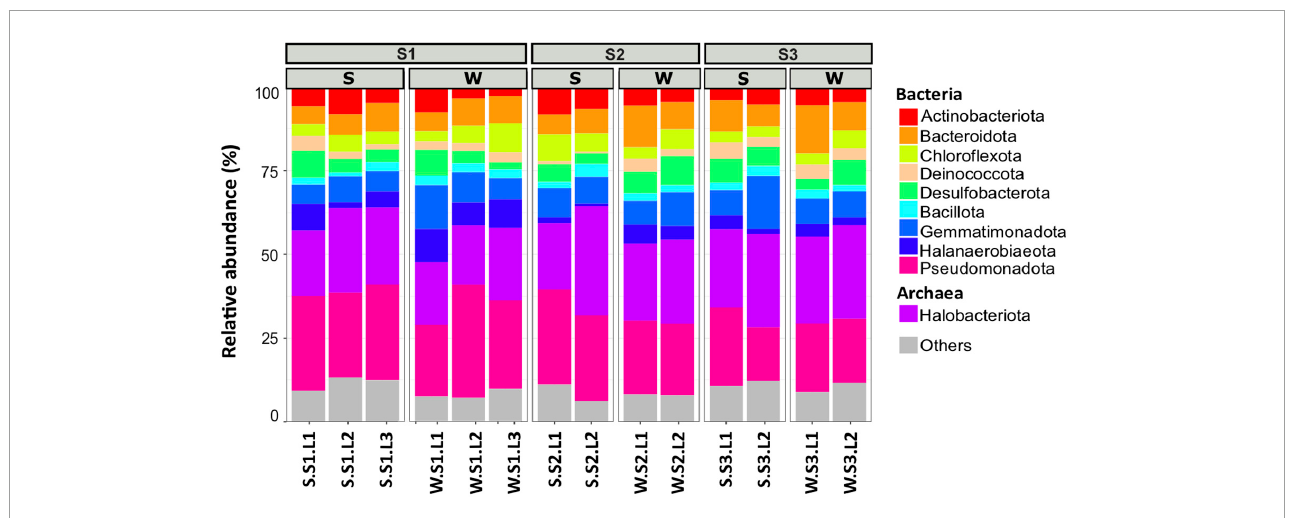
FIGURE2 Microbial community composition of the 10 most abundant phyla in different layers (L1, L2, L3 or L1, L2) from each station (S1, S2, S3) at summer (S, dry period) and winter (W, wet period). Each bar plots represents the mean of three biological replicates (except for S.S1.L2, n = 2). Others represent phyla with relative abundance <